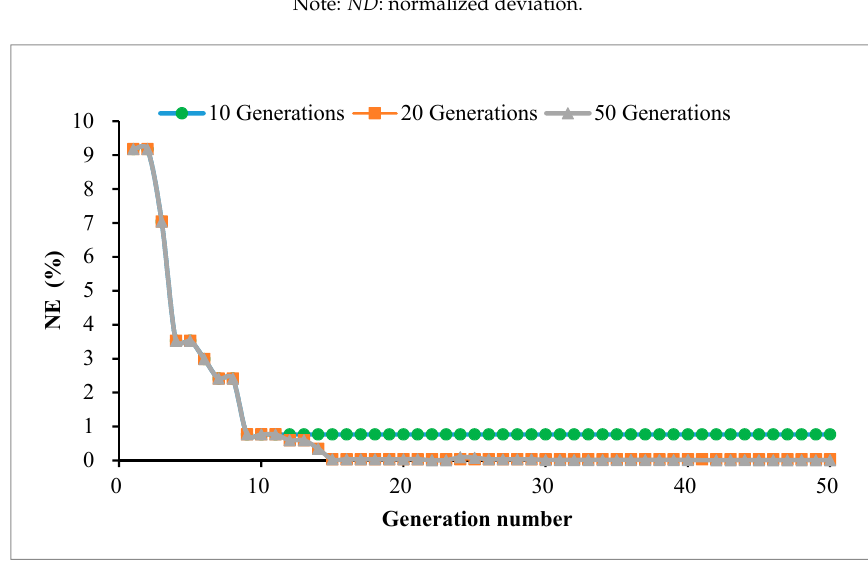
Figure 7. Effect of variation in generation number.